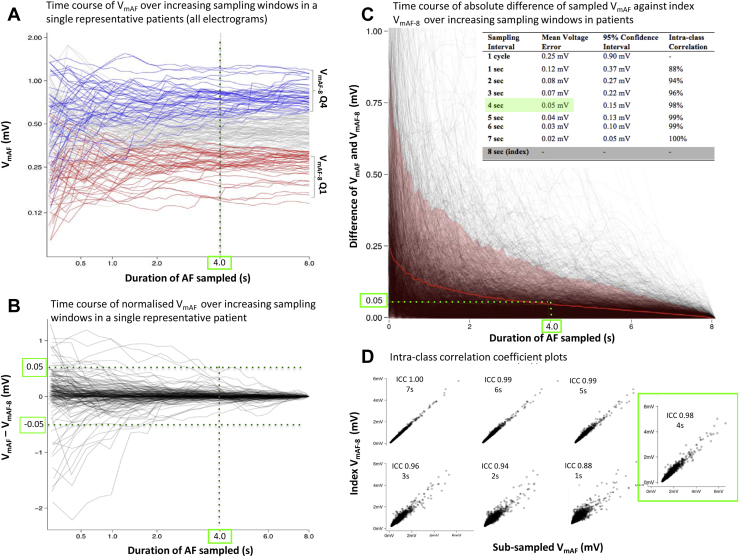
Assessment of the temporal stability of atrial fibrillation (AF) voltage. A: Time course of VmAF from a single patient. Traces in the top and bottom quartiles of VmAF are colored blue and red, respectively. By 4 seconds, crossover of VmAF between the top and bottom quartiles for all traces has occurred, as mean VAF has stabilized. B: Normalized time course of VmAF (from traces in panel A). By 4 seconds, none of the traces deviate from the index 8-second mean by more than ±0.05 mV. C: Global time course of the absolute difference between sampled and index 8-second mean AF voltage (black lines). Traces within the pink confines represent electrograms in the upper 95% confidence interval. Red line represents the mean voltage error (VME) of VmAF. D: Intraclass correlation (ICC) plots of 8-second index mean VAF (y-axis) vs subsampled VmAF values for sampling intervals ranging from 1–7 seconds (x-axis).